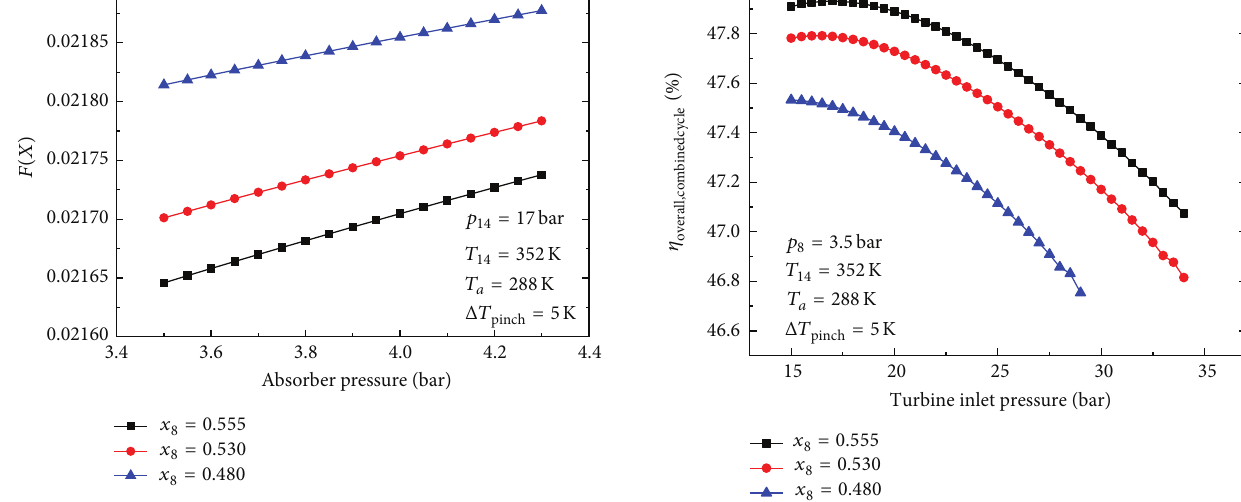
Figure 7: Variation of overall efficiency of combined cycle with turbine inlet pressure.